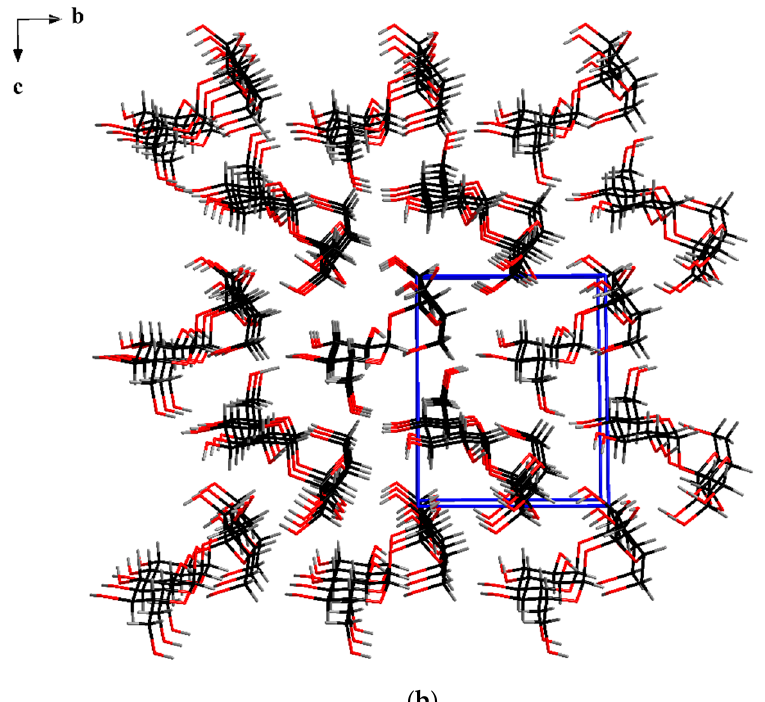
Figure 4. The crystal structure of the sucrose separated from the methanol extract of A. gigas when BMImBF 4 IL was used as an anti-solvent: ( a ) Crystal packing of six sucrose molecules, ( b ) Sucrose crystal packing structure.